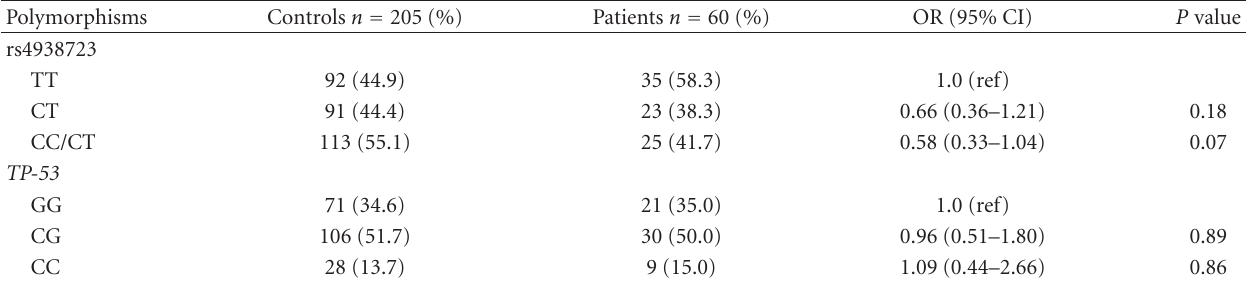
Table 6: Genotype frequencies of miR-34 rs4938723 and TP-53 Arg72Pro in male